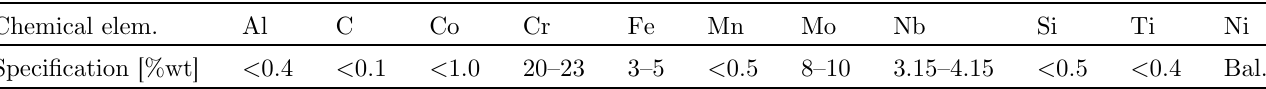
Table 1. Chemical composition of IN 625 metal powder. Chemical